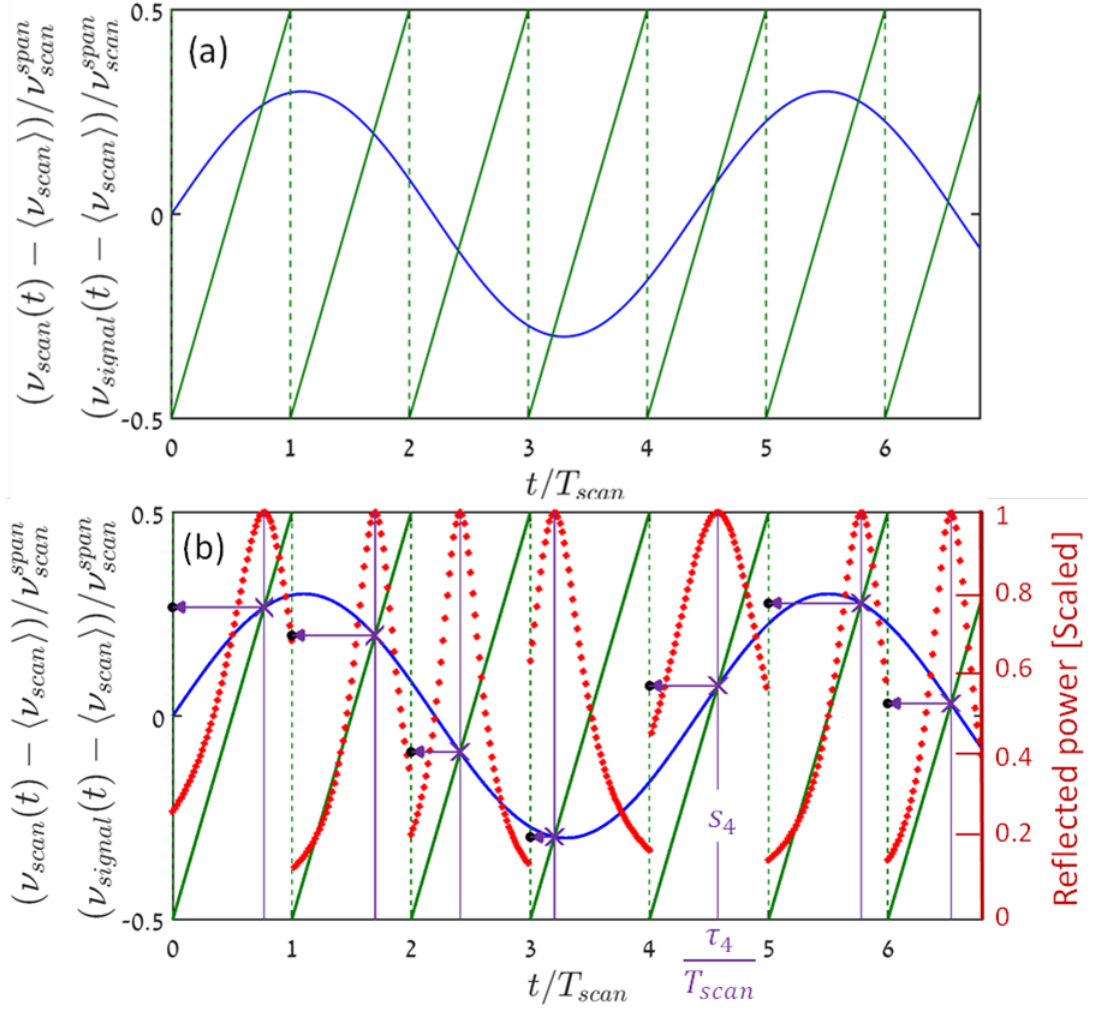
Figure 1. ( a ) A sinusoidal measurand signal of a normalized temporal frequency of f signal / f scan = 0.23 (50 Hz/220 Hz) and filling factor of ν signal − amp / ν span scan = 0.3 (solid-blue sinusoidal curve), is scanned by a periodic (every T scan ) saw-tooth waveform (green). ( b ) The saw-tooth scanning results in a time-dependent detected power (FBG reflection [7,8], or Brillouin probe amplification [11–13]: red dot curves (arbitrary units). The purple X’s designate the intersection of the signal with the saw-tooth waveform, also indicating the instants where the detected power reaches it maximum. The black filled circles are the measurand sampled values (the ordinates of the X’s), attributed to the beginning of the corresponding scan periods. Only the middle ~6 scan periods are shown from a simulated temporal range of [ − 550 549 ] T scan